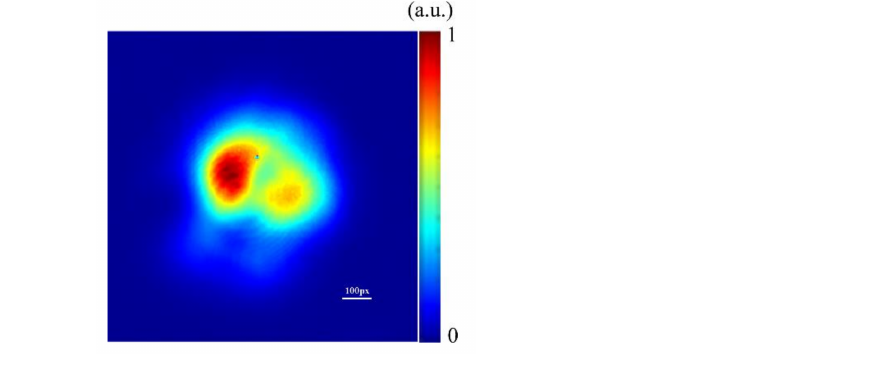
Figure 3. Profile of the output beam from the high-power laser (scalebar: 100 pixels).